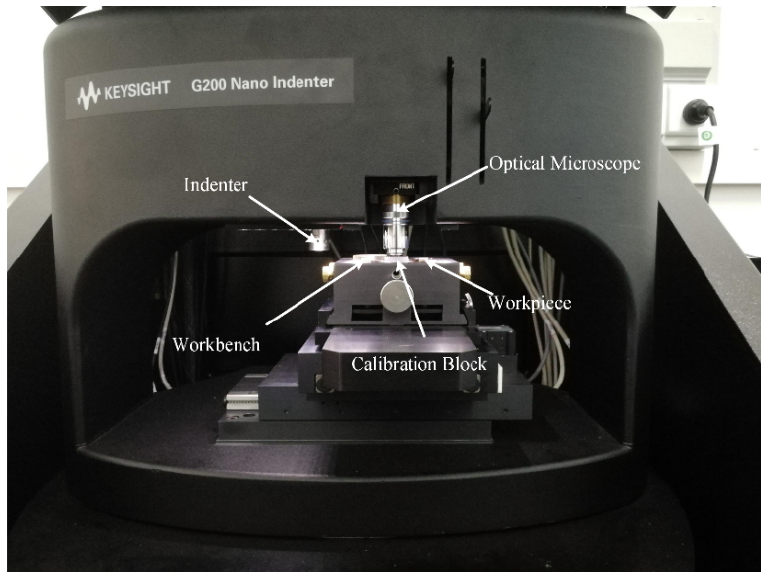
Figure 1. Experimental setup.